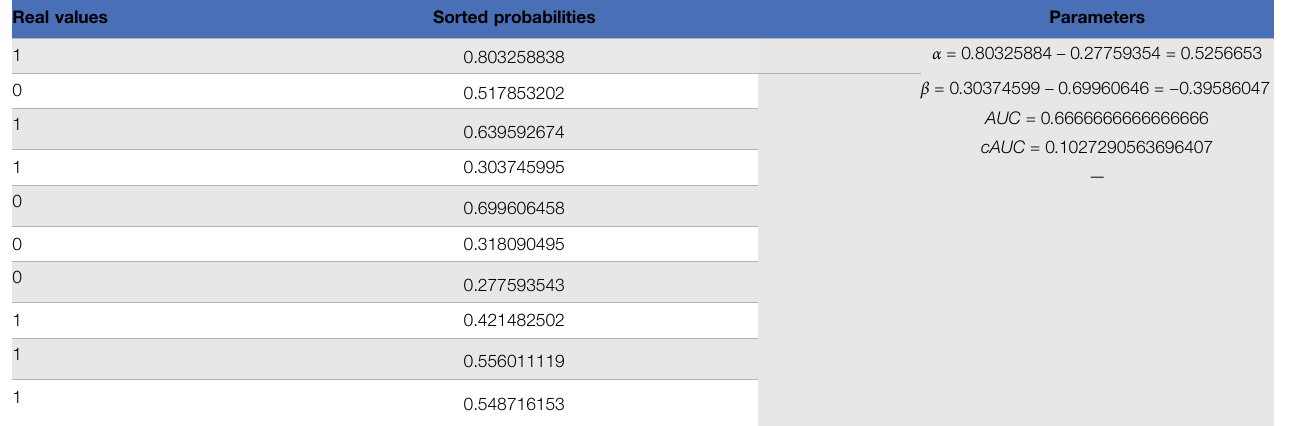
TABLE 11 | Comparison of AUC and the proposed AUC for a random case. Real values Sorted probabilities